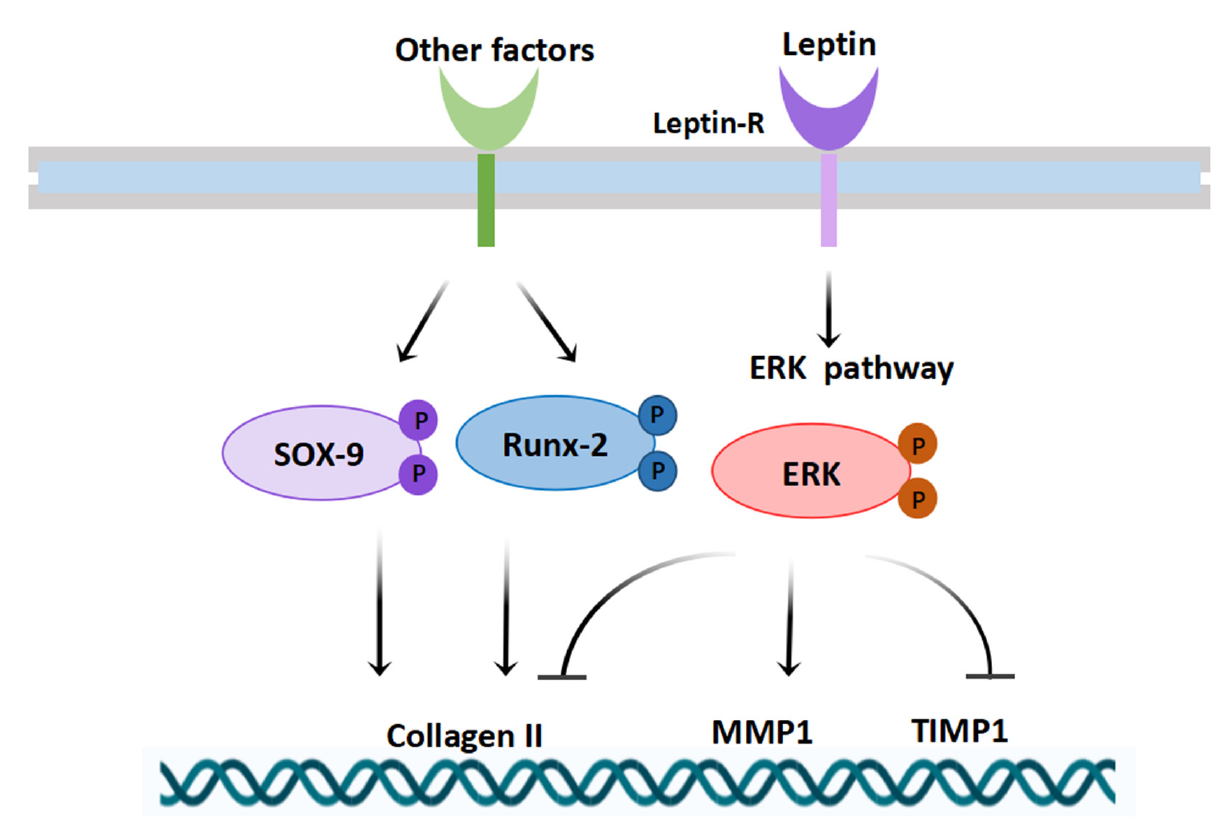
Figure 8. Possible mechanism of maternal obesity-induced cartilage damage in the newborn male mice.